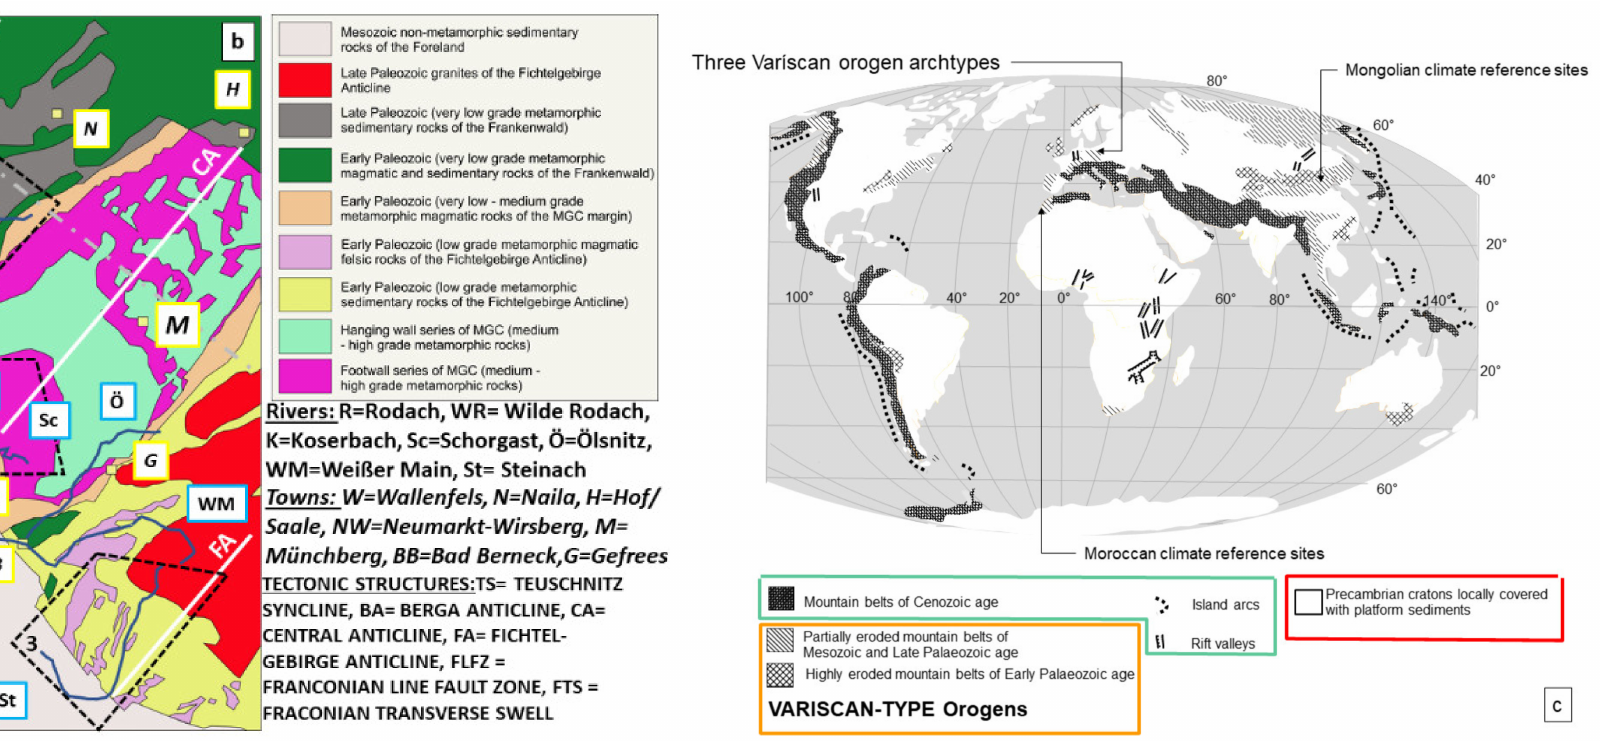
Figure 1. Position and the geological setting of the study area in SE Germany with three type localities framed by stippled line: 1. VLG-type area, 2. LHG-type area, 3. LGG-type area. For features of each reference site see Table 1. ( a ) Position of the study area in the Central European Variscides in SE Germany at the NW edge of the uplifted basement of the Bohemian Massif (BM) and at the NE margin of the South German Block (SGB) representative of the Mesozoic and Cenozoic foreland basin. Rivers, towns and tectonic structures as well as geology are shown on the right-hand side, ( b ) The geological setting of the three type localities at the NW edge of the Bohemian Massif. Geological basis [35] ( c ) The position of the study areas referred to in the text in relation to the geomorphological-geodynamic setting and the distribution of Variscan-type orogens Maturity of crustal section: green: pre-mature, orange: mature, red: super-mature